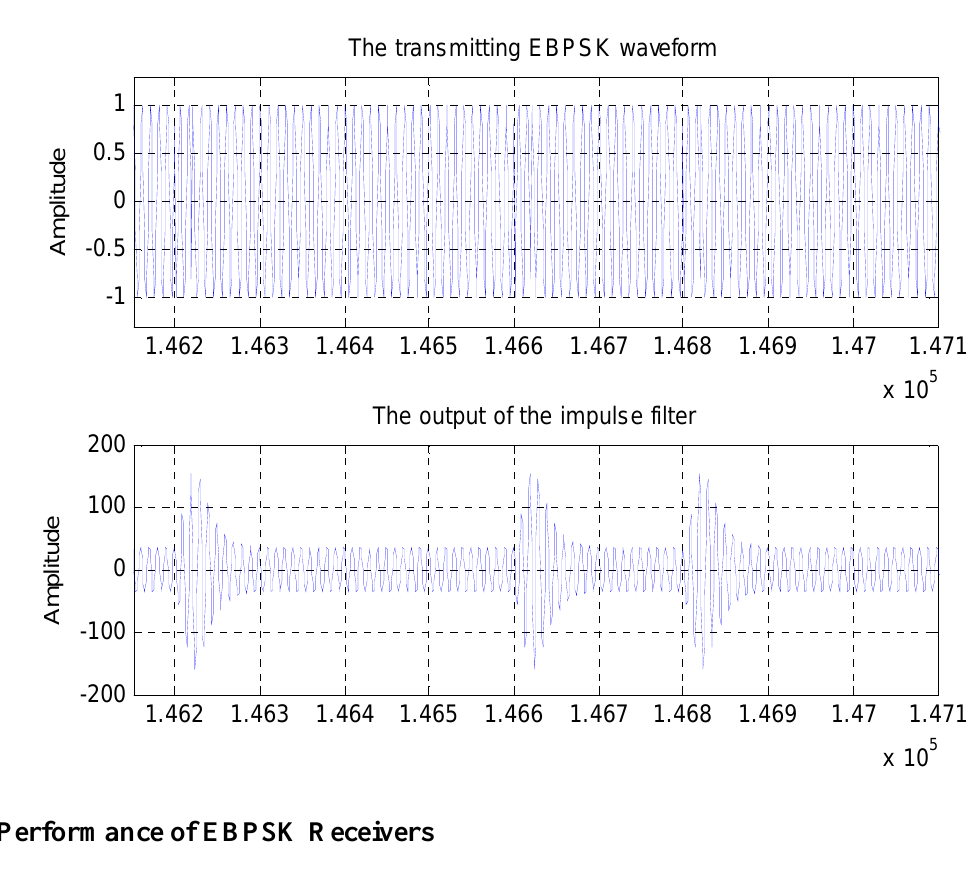
Figure 3. The output of the impacting filter to the EBPSK modulated